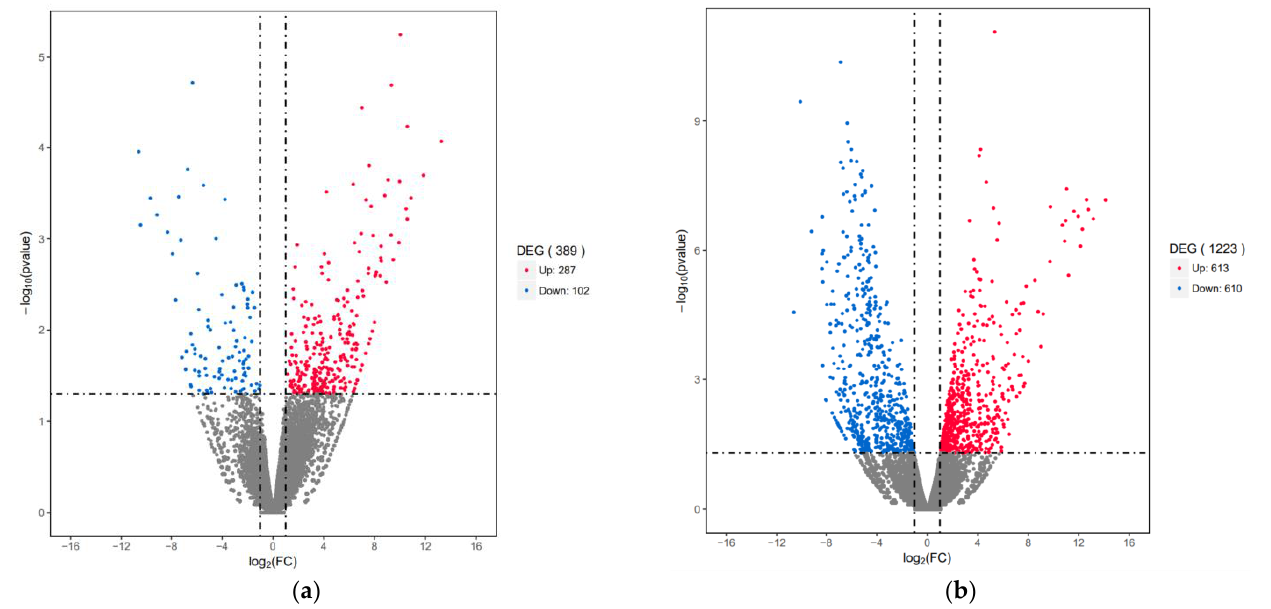
Figure 3. The number of differentially expressed genes between different groups: ( a ) LS _ O vs. CG _ O group; ( b ) LS _ E vs. CG _ E group. Significantly up - regulated and down - regulated genes are indicated in red and blue, respectively, and those not significantly different are in gray. Table 1. The GO term of related to ovarian development in the LS _ O vs. CG _ O group. Term Significant/Annotated Up/Down